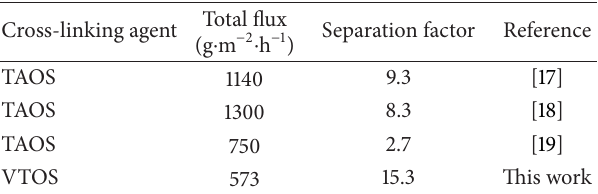
Table 3: Pervaporation performance of different PDMS-VTOS using cross-linking